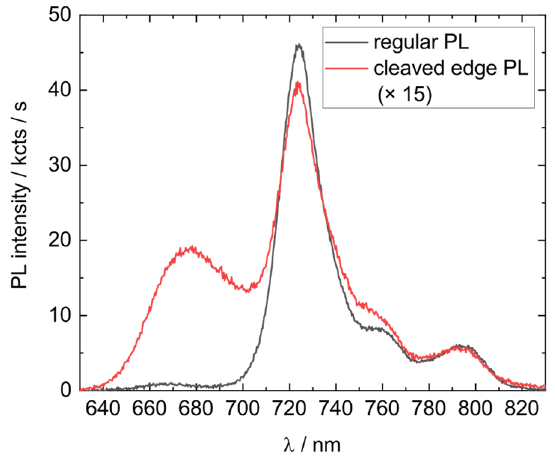
Figure A5. Comparison of regular and cleaved-edge ensemble PL. Intensity for cleaved-edge PL multiplied by a factor of 15 to match regular PL intensity.